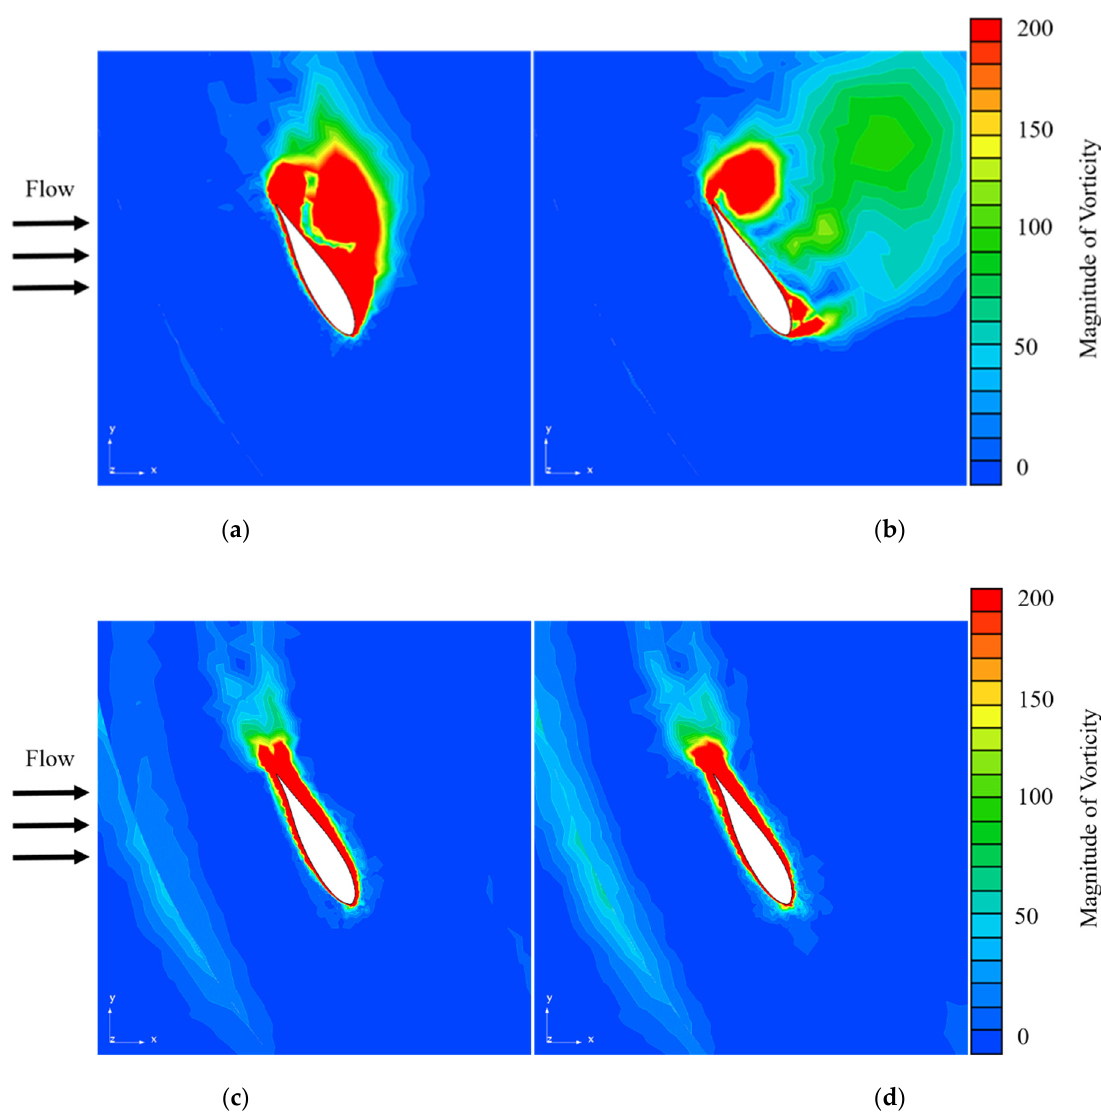
Figure 15. Vorticity around single blade with respect to tip speed ratio: ( a ) TSR = 1, ( b ) TSR = 2, ( c ) TSR = 3.5, ( d ) TSR = 5.